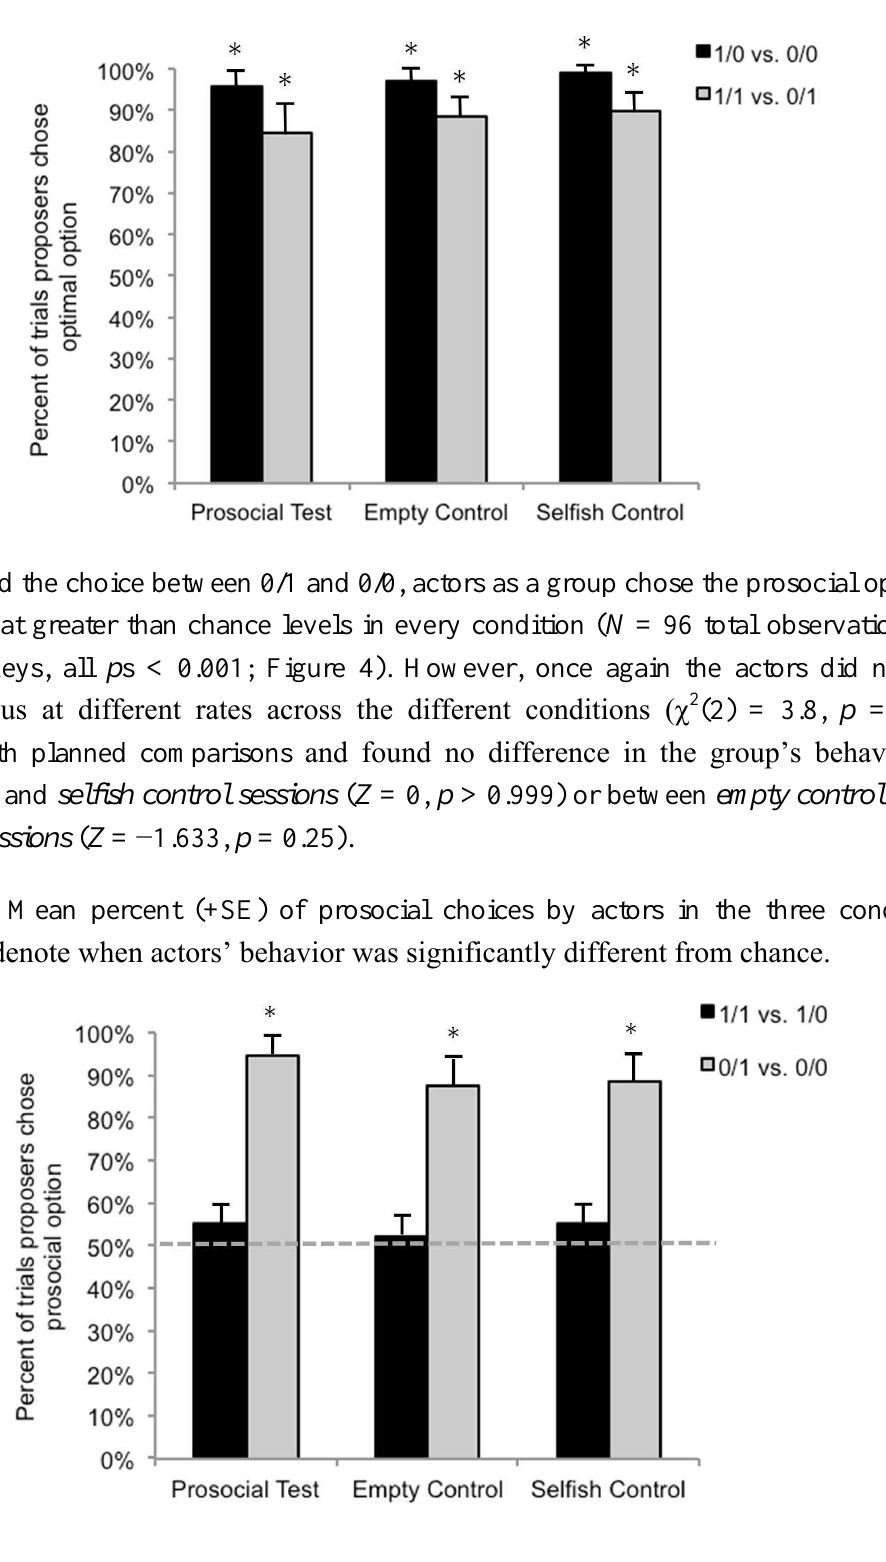
Figure 3. Mean percent (+SE) of optimal choices by actors in the three conditions. Asterisks denote when actors’ behavior was significantly different from chance.